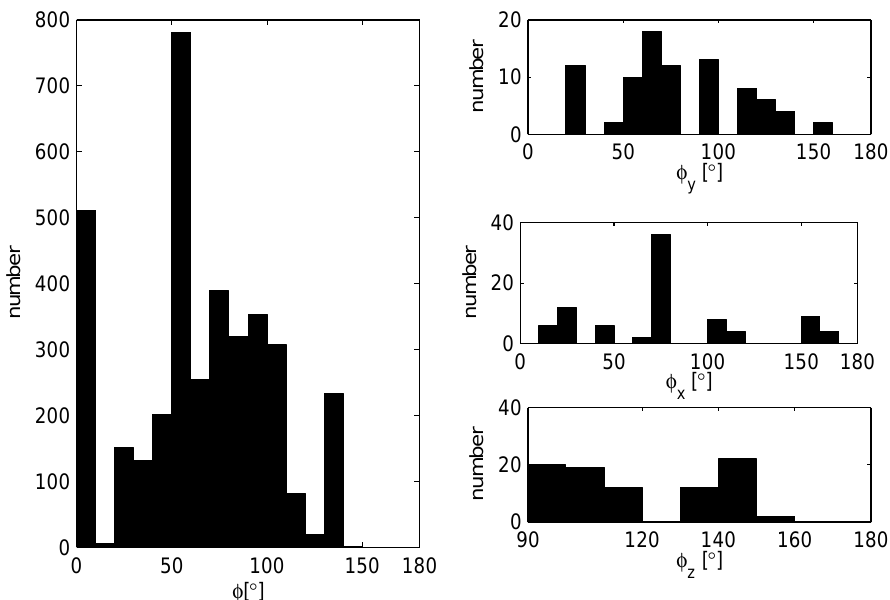
Fig. 6. The histograms of the crossing angles of every two slants in the chosen voxels in Fig. 5 (left) at station Bergen. The corresponding cutting angles with axis vectors e x , e y , e z and a spread of dφ x = 142 . 75 ◦ , dφ y = 129 . 37 ◦ , dφ z = 53 . 81 ◦ are shown on the right side.